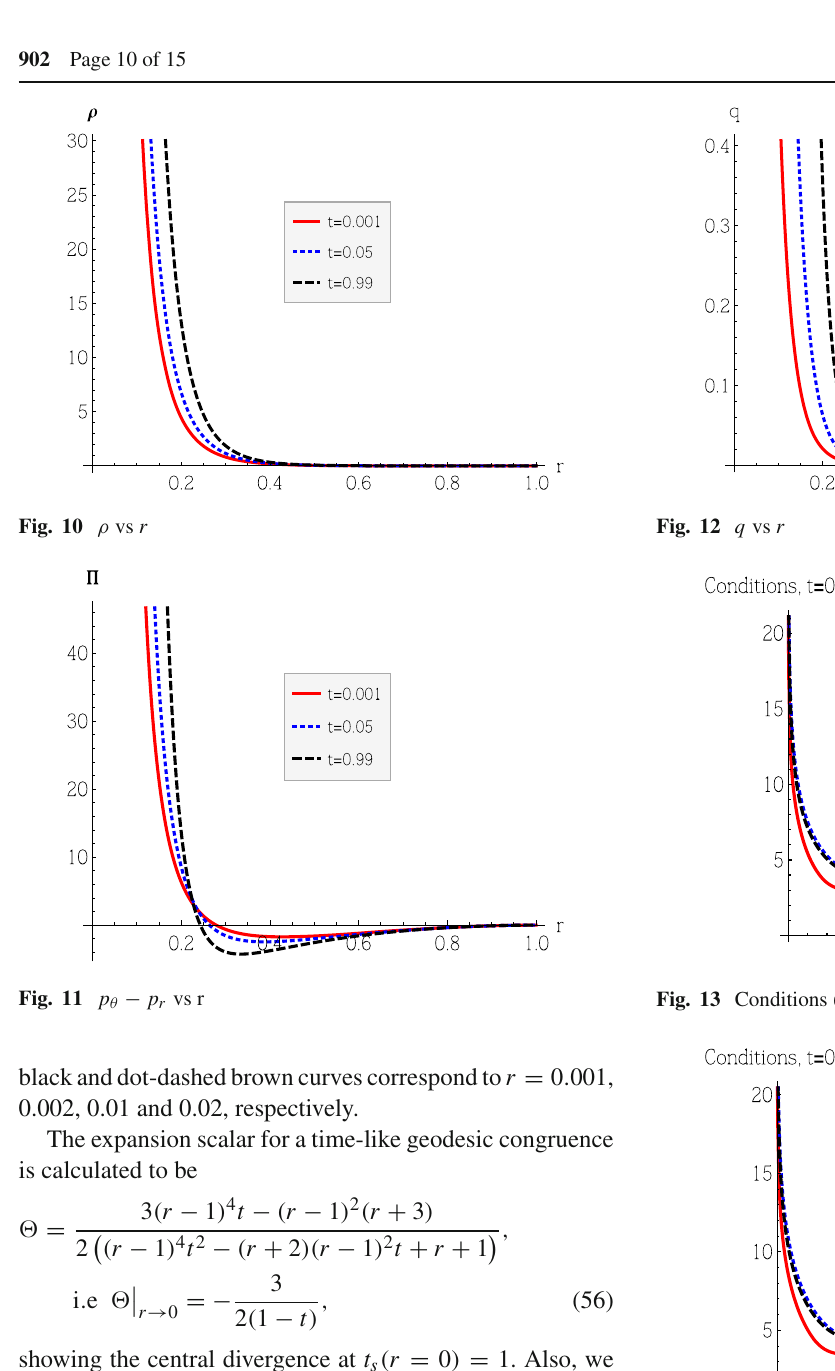
tion of r , for t = 0 . 001 (thick red), 0.5 (dotted blue) and 0.99 (dashed black), respectively. These are computed from Eq. (6) and we have set η = 10 and α = 10 − 3